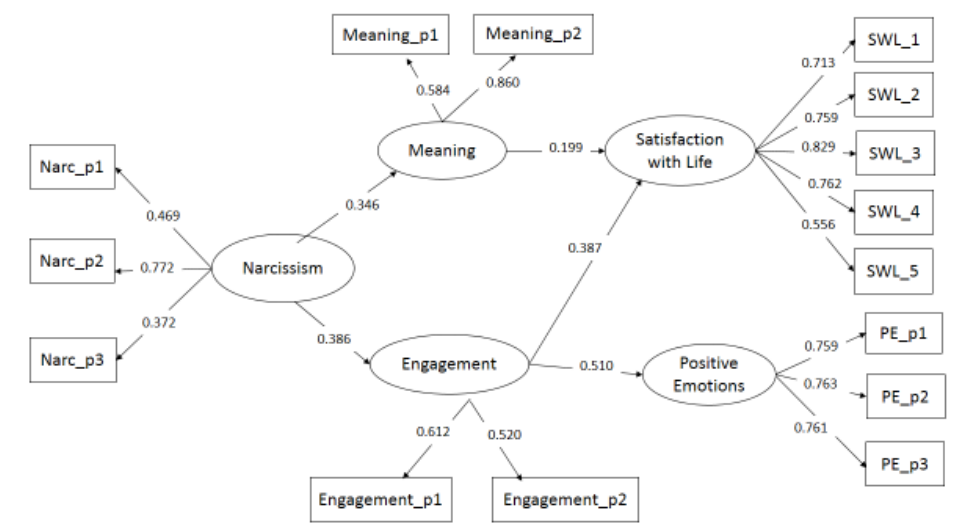
Figure 1. Mediation e ff ects of paths of happiness in the relationship between narcissism and life satisfaction and positive emotion (N = 460). Only significant regression coe ffi cients with standardized coe ffi cients are reported. Table 2. Significant indirect e ff ects of narcissism on life satisfaction and positive emotion. Indirect E ff ect 95% CI Point